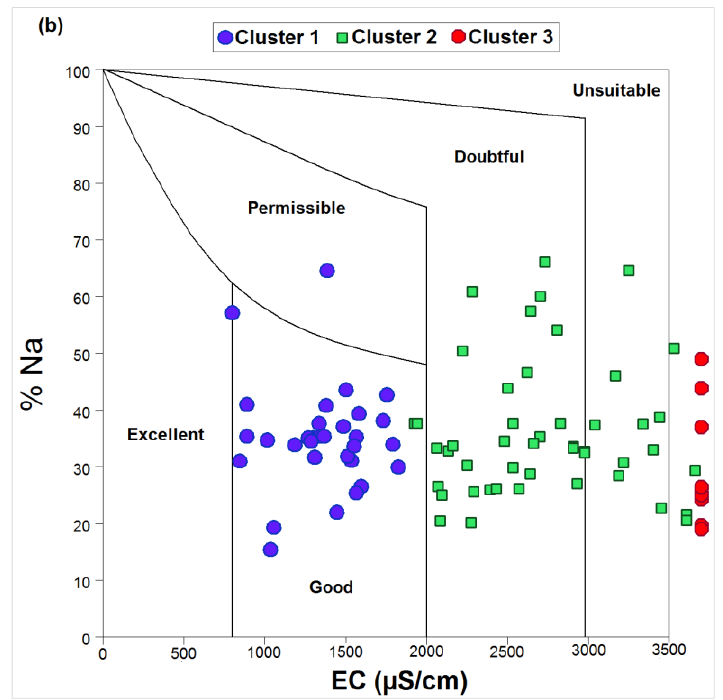
Figure 11. US salinity diagram ( a ); Willox diagram ( b ).